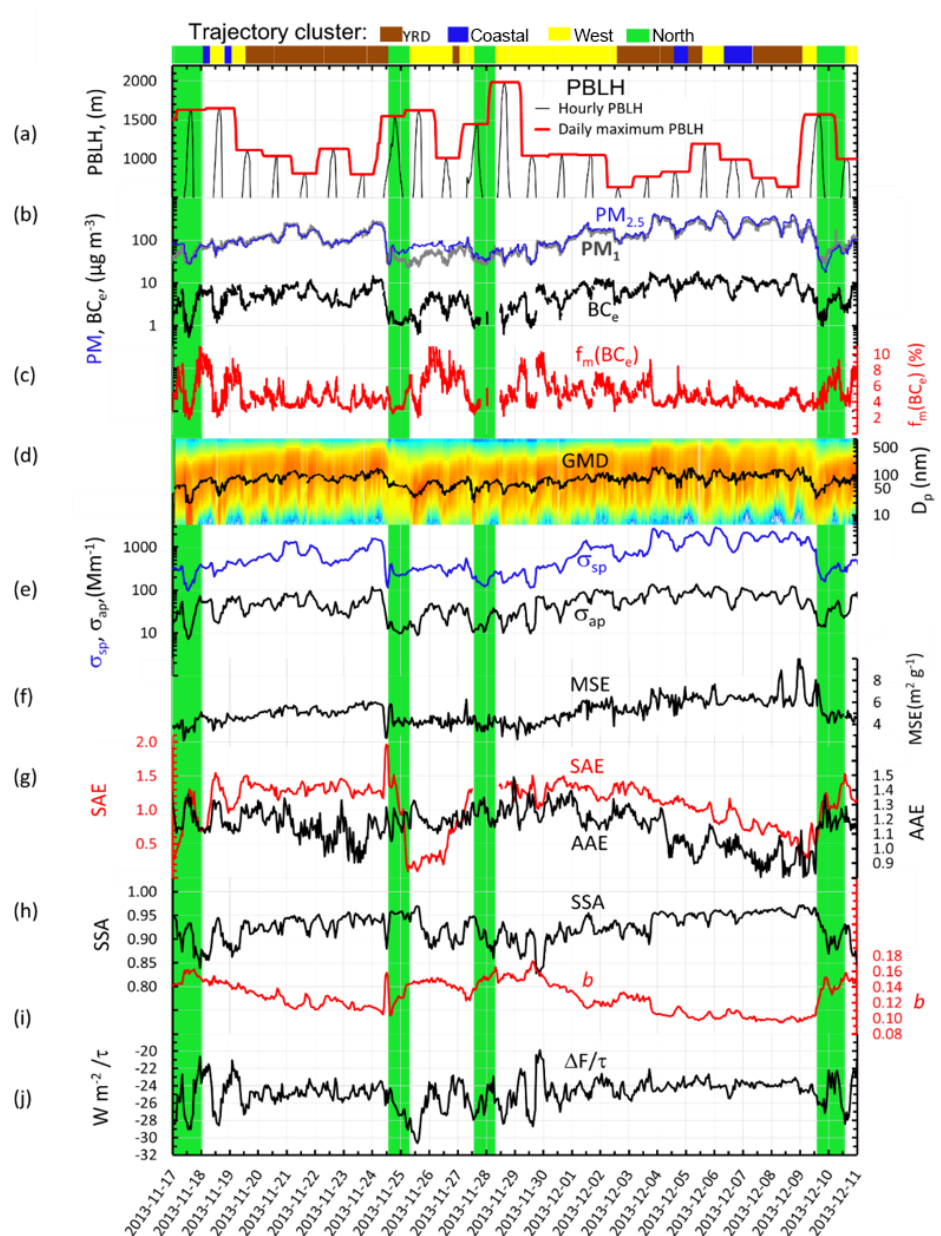
Figure 9. Hourly-averaged aerosol optical properties, mass concentrations, and modeled boundary layer height during a polluted period 17 November 2013–11 December 2013. Top: time series of trajectory clusters shown with color coding, (a) PBLH: planetary boundary layer height, (b) PM 2 . 5 and PM 1 : mass concentrations of particles smaller than 2.5 and 1µm, BC e : equivalent black carbon concentration, (c) f m (BC e ) : mass fraction of BC e , (d) particle number size distribution and GMD: geometric mean diameter, (e) σ sp : scattering coefficient at λ = 525nm, σ ap : absorption coefficient at λ = 520nm, (f) MSE: mass scattering efficiency at λ = 525nm, (g) SAE and AAE: scattering and absorption Ångström exponents, (h) SSA: single-scattering albedo at λ = 520nm, (i) b : backscatter fraction at λ = 525nm, and (j) (cid:49)F/τ : aerosol radiative forcing efficiency at λ =